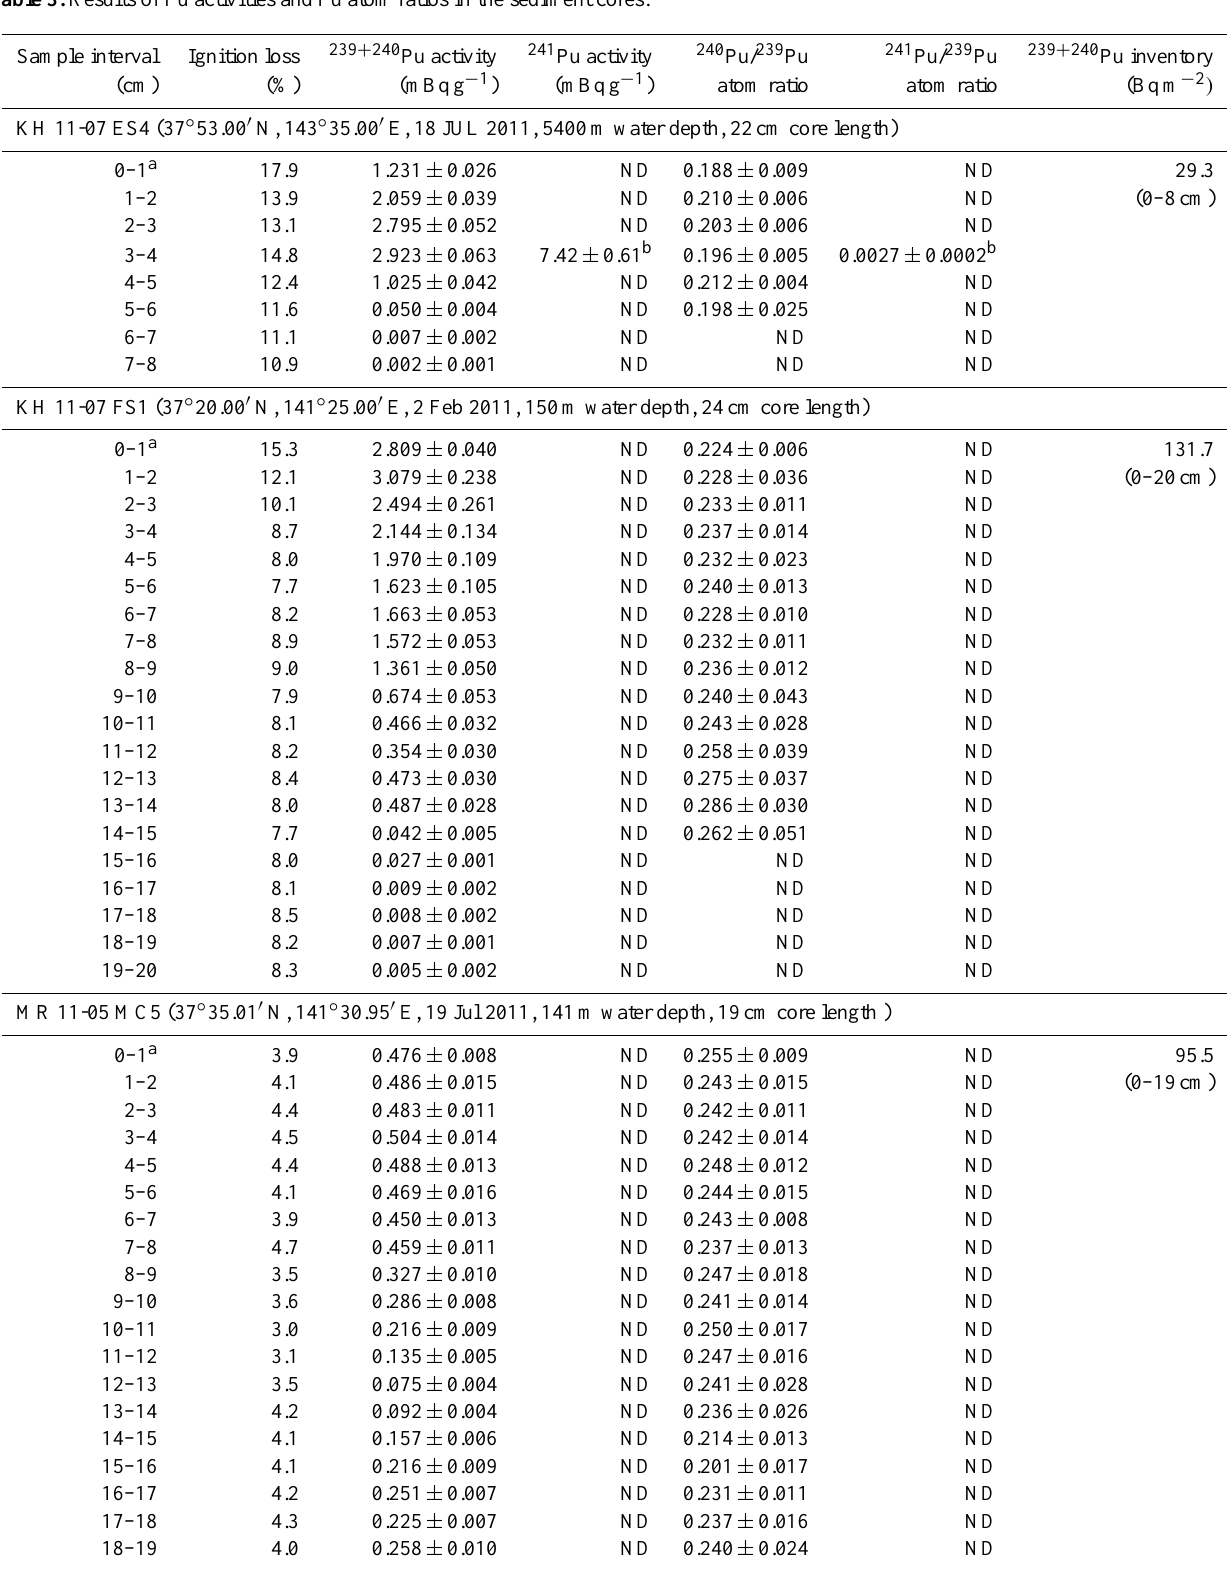
Table 3. Results of Pu activities and Pu atom ratios in the sediment cores. Sample